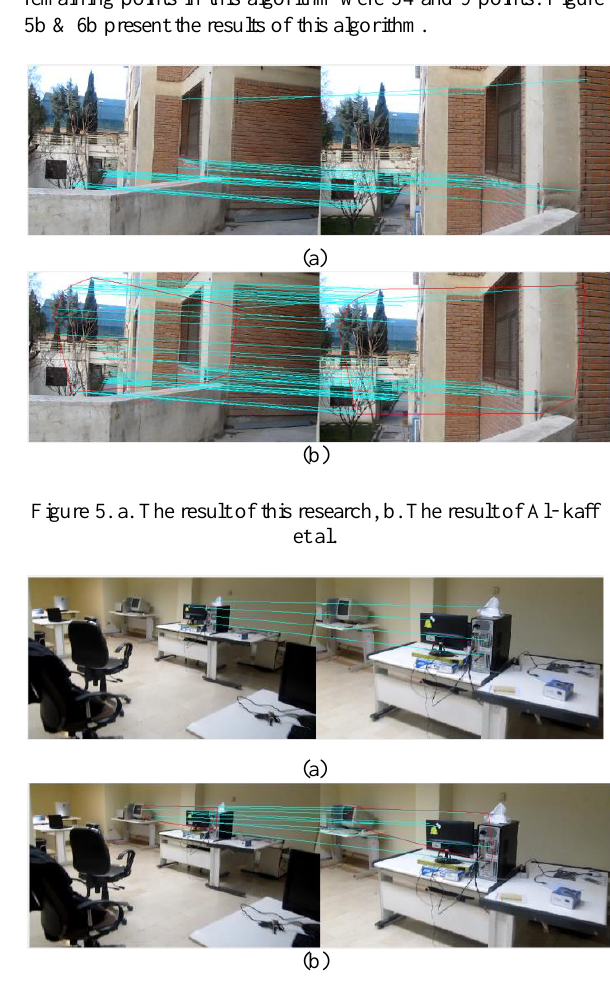
Figure 6: a. The result of this research, b. The result of Al- kaff et